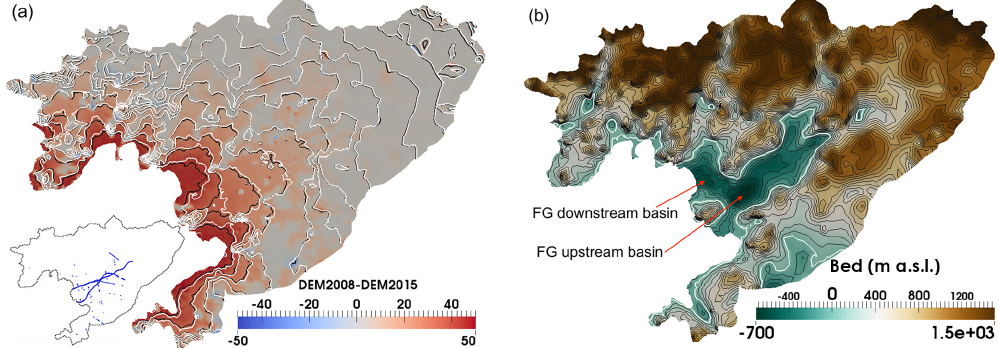
Figure 2. (a) Surface elevation difference between 2008 and 2015 (2008 minus 2015) with black and white contours (interval: 200m) representing the surface elevation in 2008 and 2015, respectively. Inset map shows the location in the research domain with blue points showing the available elevation data points used to extract the hypsometric model of elevation change from 2008 to 2015 (Zhao et al., 2017). (b) Bed elevation data “bed_zc” (metres above sea level, ma.s.l.) with two basins “FG downstream basin” and “FG upstream basin” from Zhao et al. (2018). The black contours show the bed elevation with an interval of 100m. The white contour represents the sea level used in this